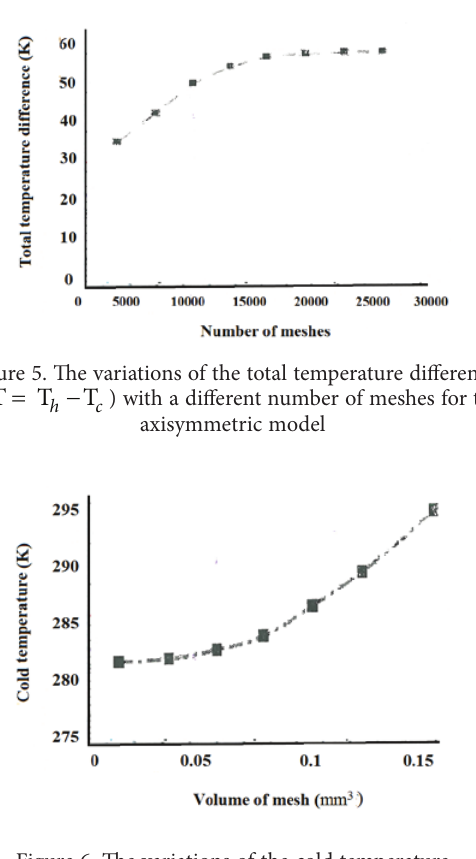
Figure 6. The variations of the cold temperature outlet ( T c ) with the volume of each mesh (mm 3 ) r the three-dimensional